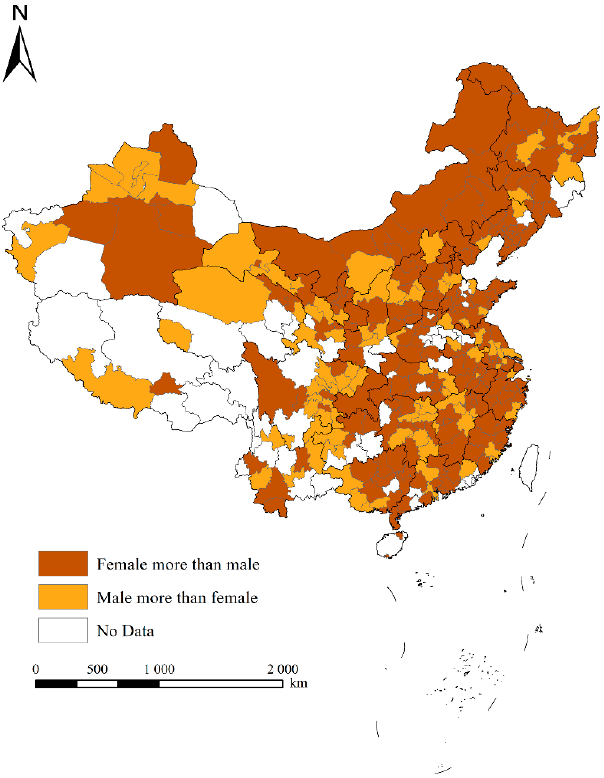
Figure 2. The spatial pattern of the settlement intention of the gender ratio of elderly people.